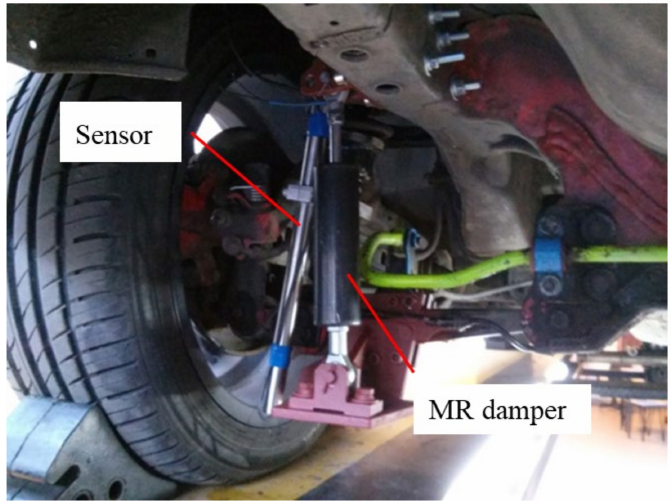
Figure 19. Vehicle with controlled MR